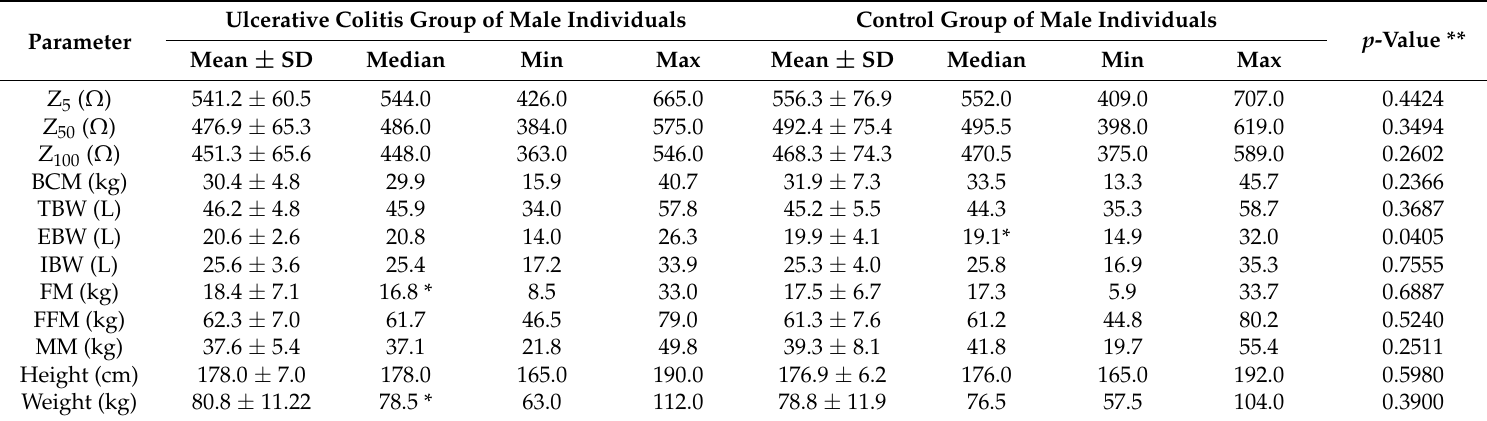
Table 1. The results of body composition measured using bioimpedance method for ulcerative colitis and control groups of male individuals. Parameter